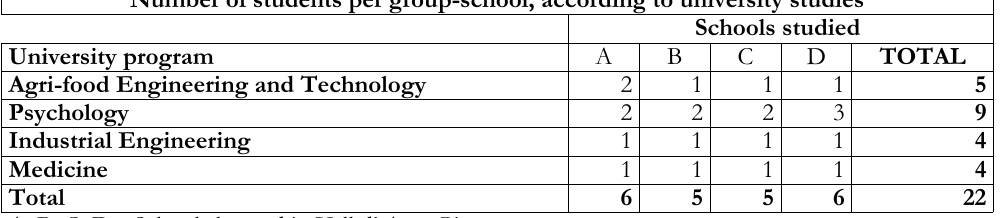
Table 1. Student assignment to each school, according to university degree